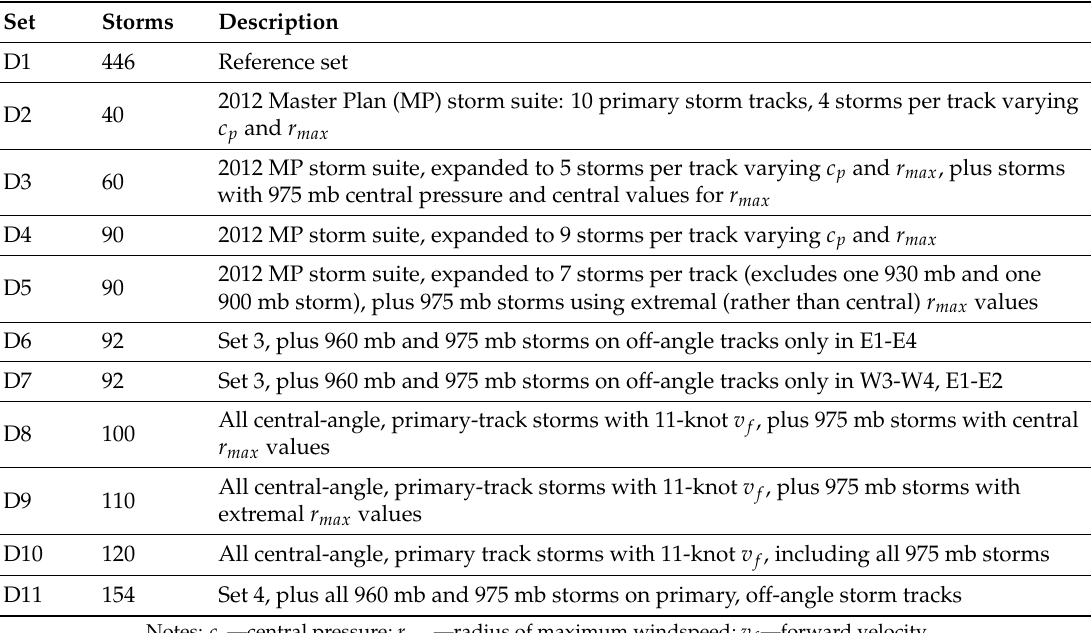
Table 2. Characteristics of storm suites selected for detailed